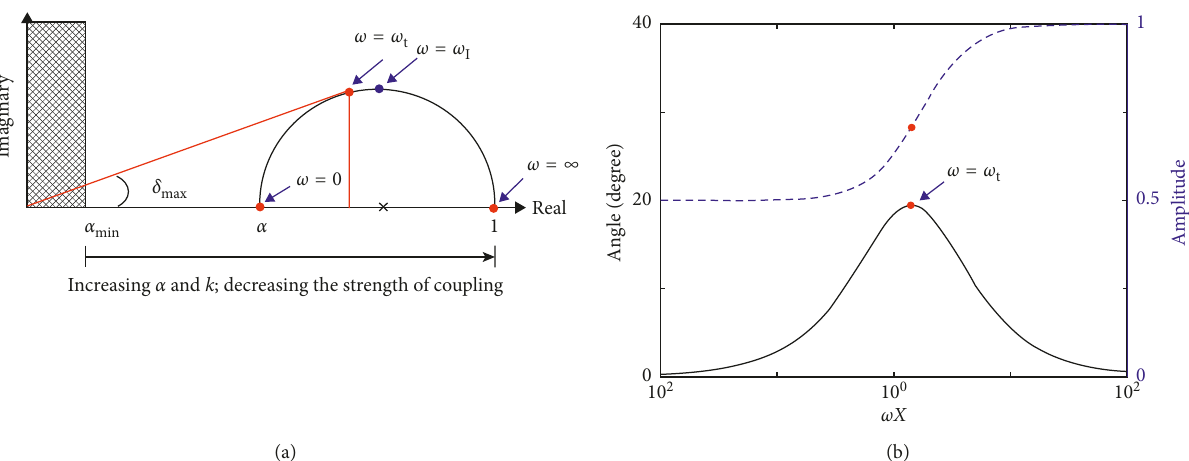
1 with κ j ω X j αω X ω α 1 / 1 for α 1 κ o o (cid:31) 1. (a) Polar plot and (b) amplitude (dashed ( ) (cid:31) ( + ) ( + ) (cid:31) ( + ) −